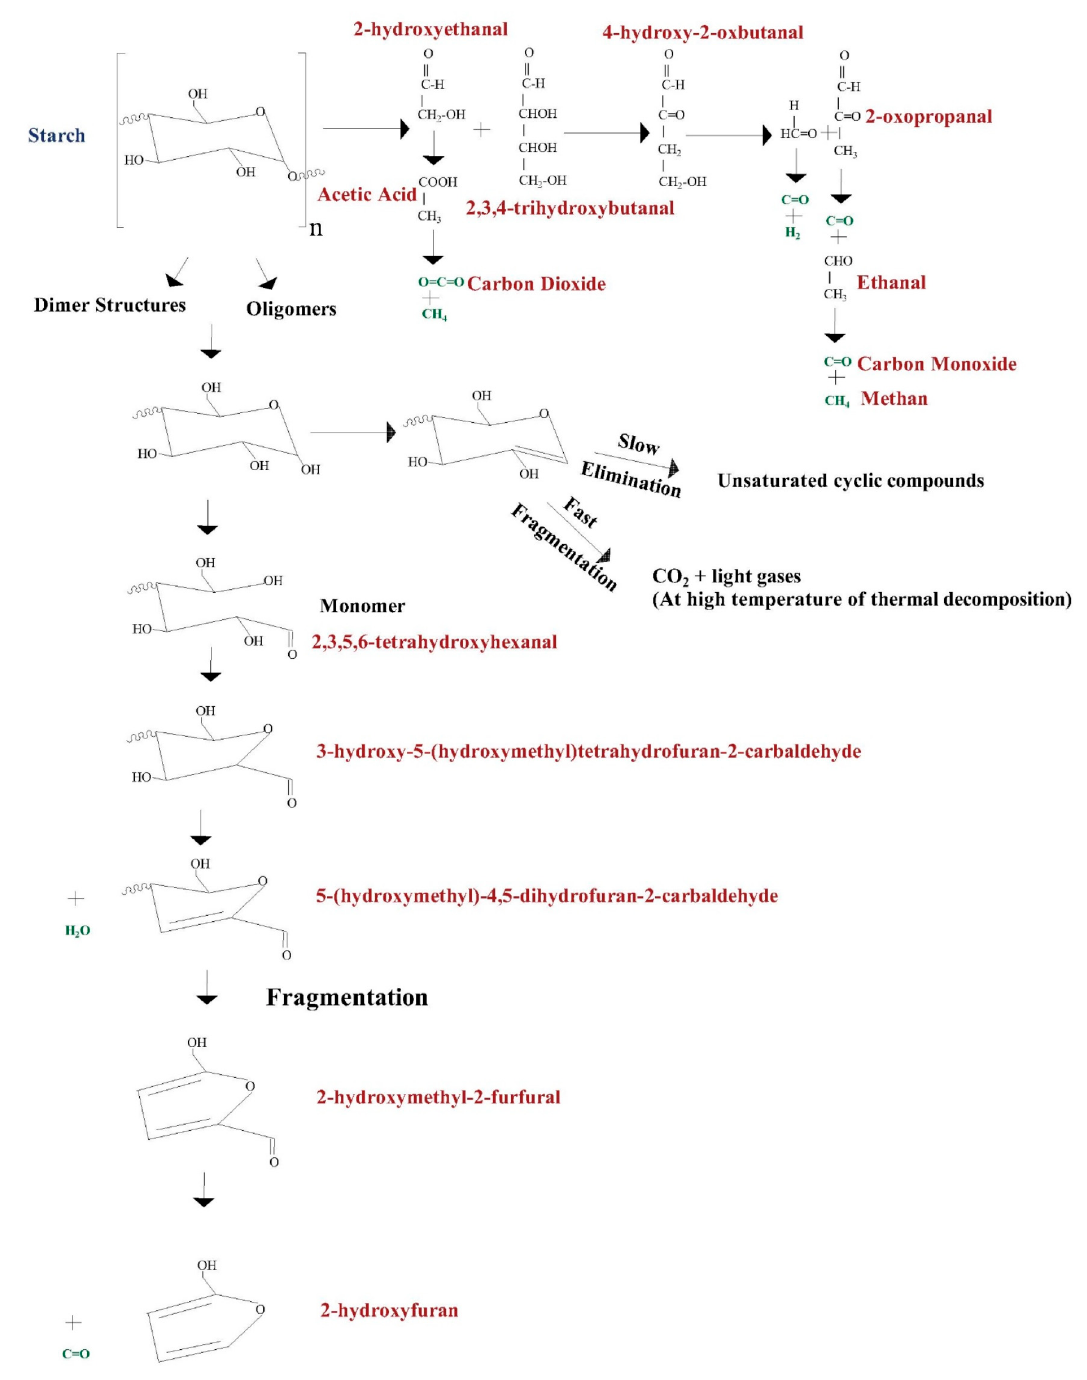
Figure 3. Possible pathways during starch degradation [17].